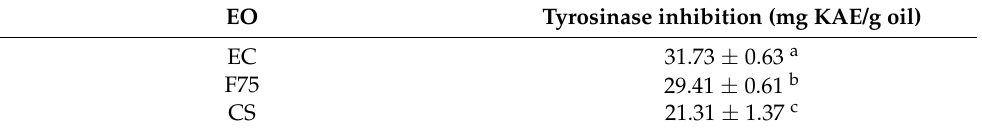
Table 5. Antityrosinase activity.